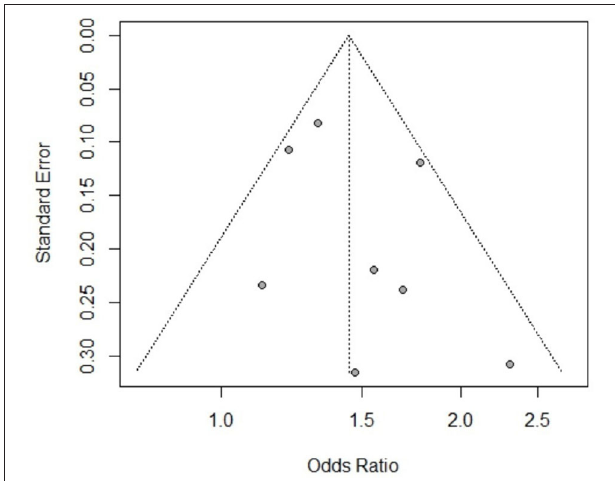
FIGURE 5 | Funnel chart of AE risk factor